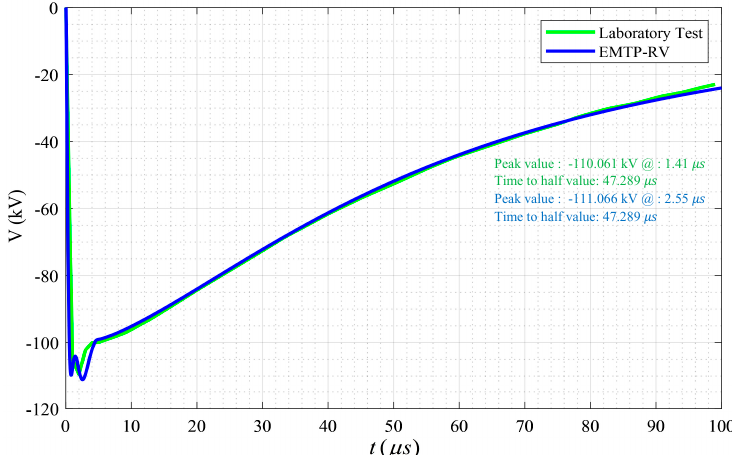
Figure 13. Applied impulse 110 kV in the presence of 35 μH filtered spark gap, laboratory test and EMTP-RV model.